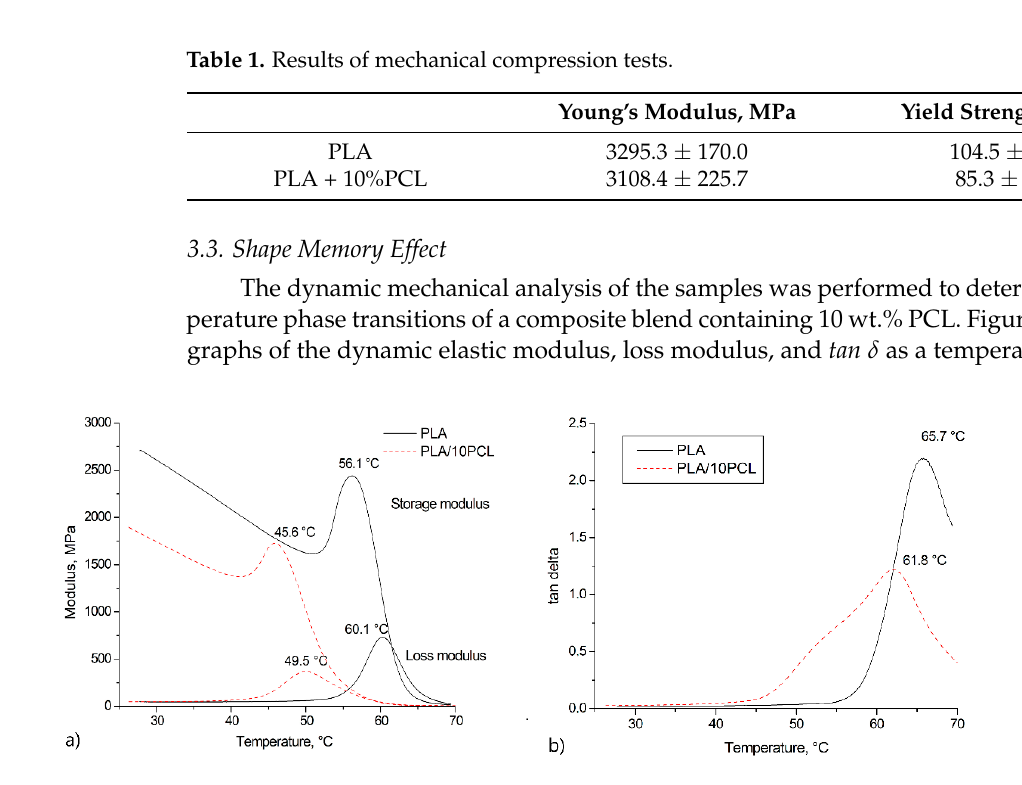
Table 1. Results of mechanical compression tests.